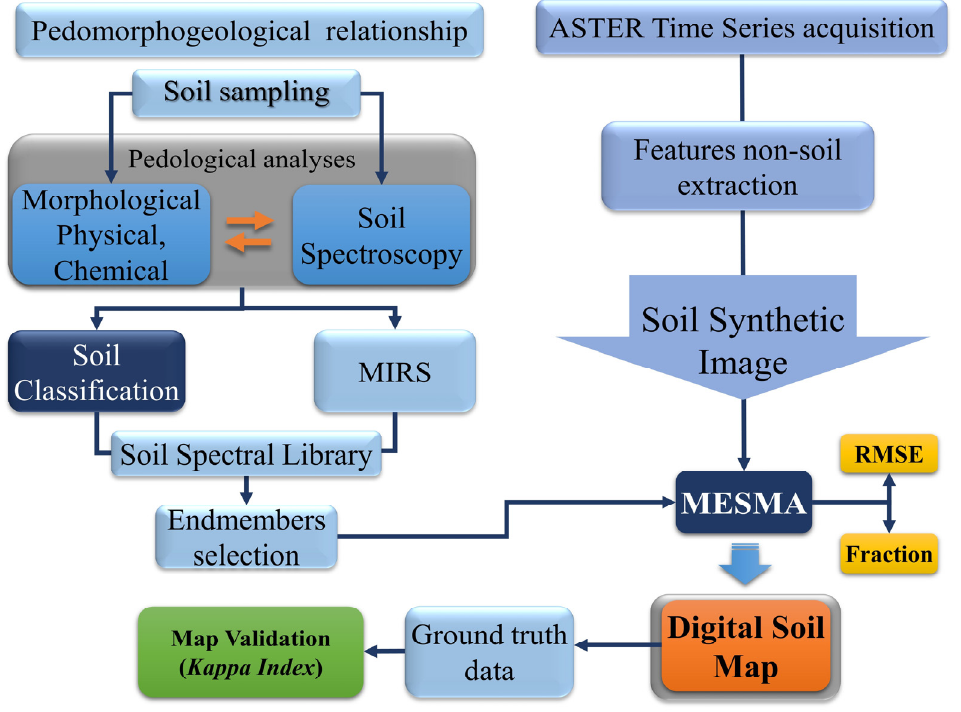
Figure 2. Methodology’s flowchart. MIRS: Morphological Interpretation Reflectance Spectrum; MESMA: Multiple Endmember Spectral Mixture Analysis; RMSE: Root Mean Square Error.